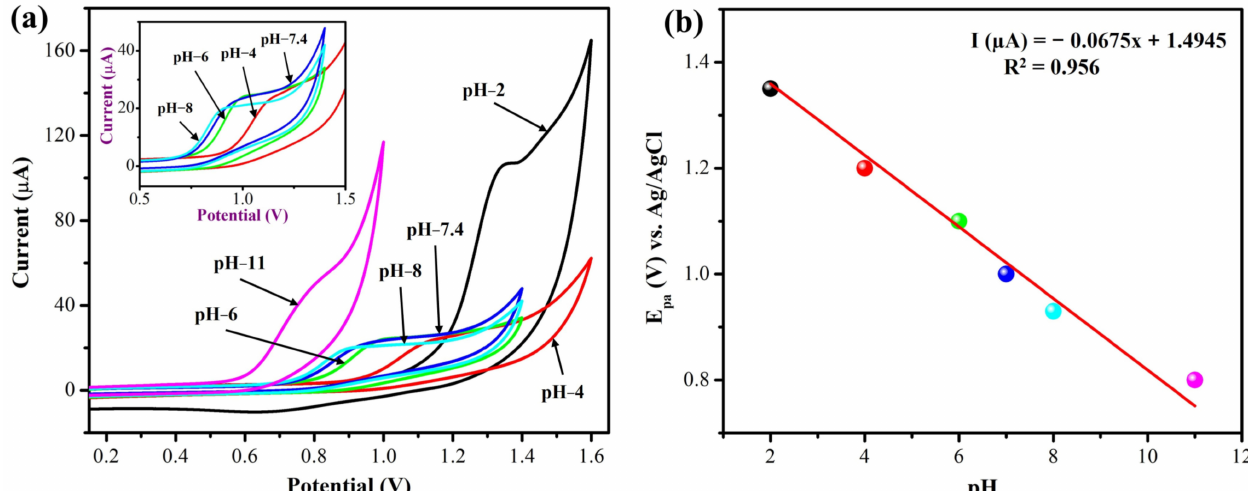
Figure 11. ( a ) CVs were carried out in different pH buffer solutions with 1 mM NIC at a scan rate of 50 mV s − 1 . Inset: Enlarged view of CVs of pH 4, 6, 7.4 and 8. ( b ) Relationship between the different pH and oxidation potential of NIC. (The CVs were recorded in different buffer solutions using the 1 mM nicotine. The phosphate buffer (pH 6–8), KCl/HCl buffer (pH 2), acetic acid/sodium acetate buffer (pH 4) and NH 4 Cl/ammonia solution (pH 11) were utilized in this experiment with 0.1 M